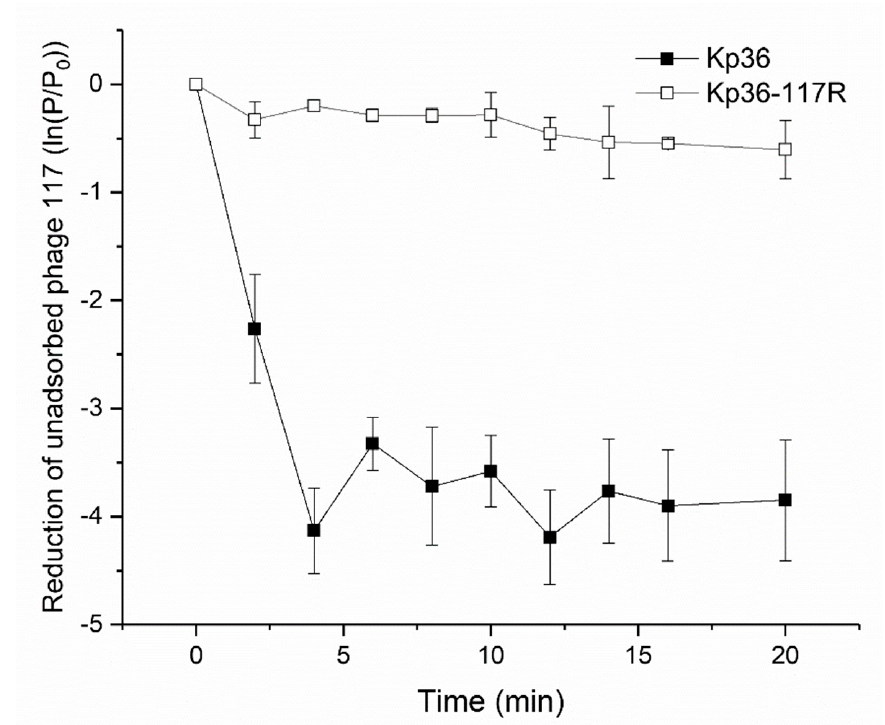
Figure 2. Phage-resistant mutant Kp36-117R displays di ff erent phage adsorption rates when compared with wild-type strain Kp36. Phage 117 was added to the mid-log phase cultures of strains Kp36 and Kp36-117R at an MOI of 0.001. Unabsorbed phage particles were harvested by centrifuge and counted by double-layer plaque assays. These experiments were performed in triplicate with error bars showing the variation between each